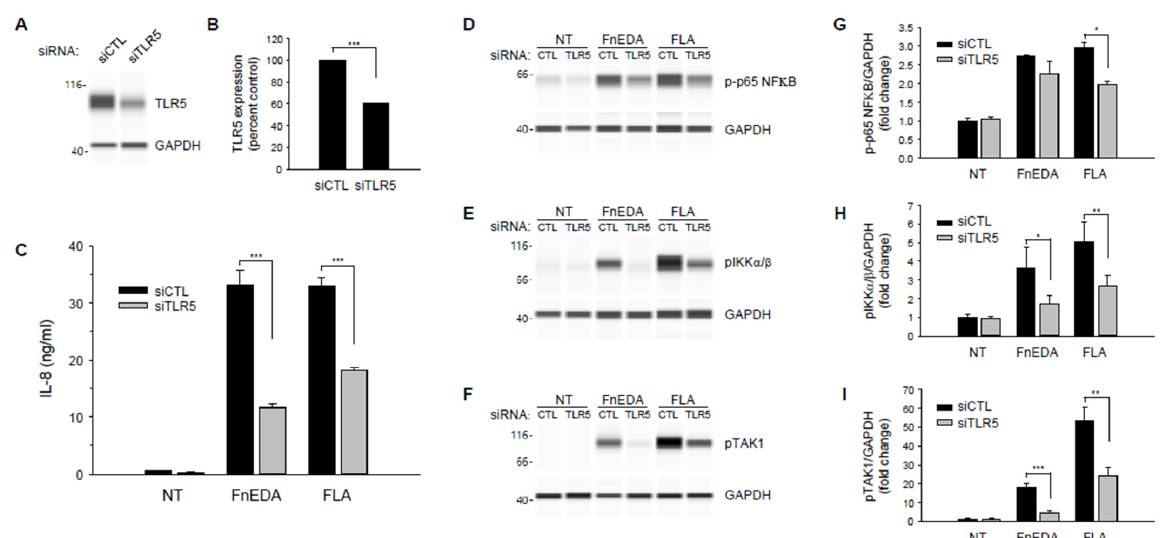
Figure 5. TLR5 knockdown suppresses FnEDA- and flagellin-induced IL-8 synthesis and NF κ B signaling in MDA-MB-468 breast cancer cells. RNA interference was used to suppress expression of TLR5 (siTLR5) in MDA-MB-468 breast cancer cells. Non-targeting siRNA (siCTL) served as control. Representative Wes-ProteinSimple assay illustrating relative TLR5 expression following gene knockdown is shown in ( A ) and quantified in ( B ) relative to GAPDH expression ( n = 3). ( C ) siRNA- treated MDA-MB-468 cells were incubated with either FnEDA (5 µ M) or flagellin (FLA, 50 ng/mL) for 4 h and IL-8 concentration in conditioned medium determined by ELISA. Data shown represent the mean ± SEM of three experiments performed in triplicate. To evaluate the effects of reduced TLR5 expression on NF κ B signaling, TLR5 knockdown cells were treated with either FnEDA (5 µ M) or flagellin (FLA, 50 ng/mL) for 1 h. Whole-cell lysates collected were analyzed by WES. Representative Wes-ProteinSimple assay for ( D ) phospho-p65 NF κ B, ( E ) phospho-IKK α / β , and ( F ) phospho-TAK1 are shown. Western analyses shown in ( D – F ) were quantified and normalized to GAPDH